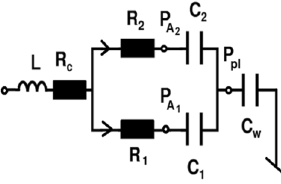
Figure 2. Respiratory system model. L, R c —central airway inertance and resistance. R 1 , R 2 , C 1 , C 2 —peripheral airway resistances and the compliance of the contralateral and ipsilateral lung. C w —chest wall compliance. P A1 , P A2 —alveolar pressure in the contralateral and ipsilateral lung. P pl —pleural pressure.